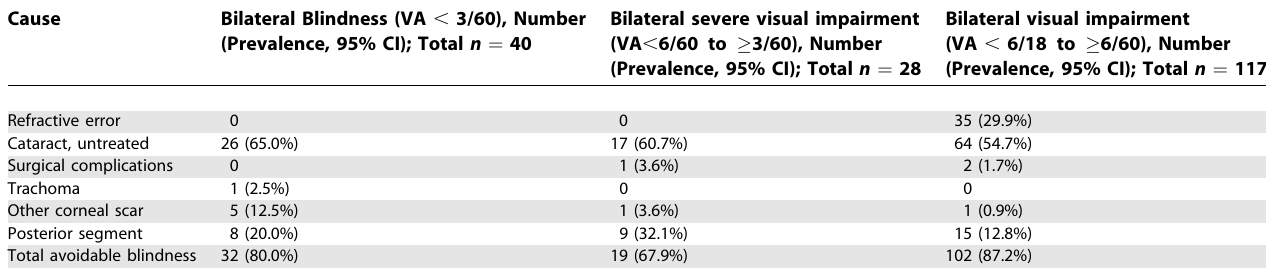
Table 3. Cause of Blindness, Severe Visual Impairment, and Visual Impairment in People with Available Correction Cause Bilateral Blindness (VA , 3/60), Number Bilateral severe visual impairment Bilateral visual impairment (Prevalence, 95% CI); Total n ¼ 40 (VA , 6/60 to (cid:2) 3/60), Number (VA , 6/18 to (cid:2) 6/60), Number (Prevalence, 95% CI); Total n ¼ 28 (Prevalence, 95% CI); Total n ¼